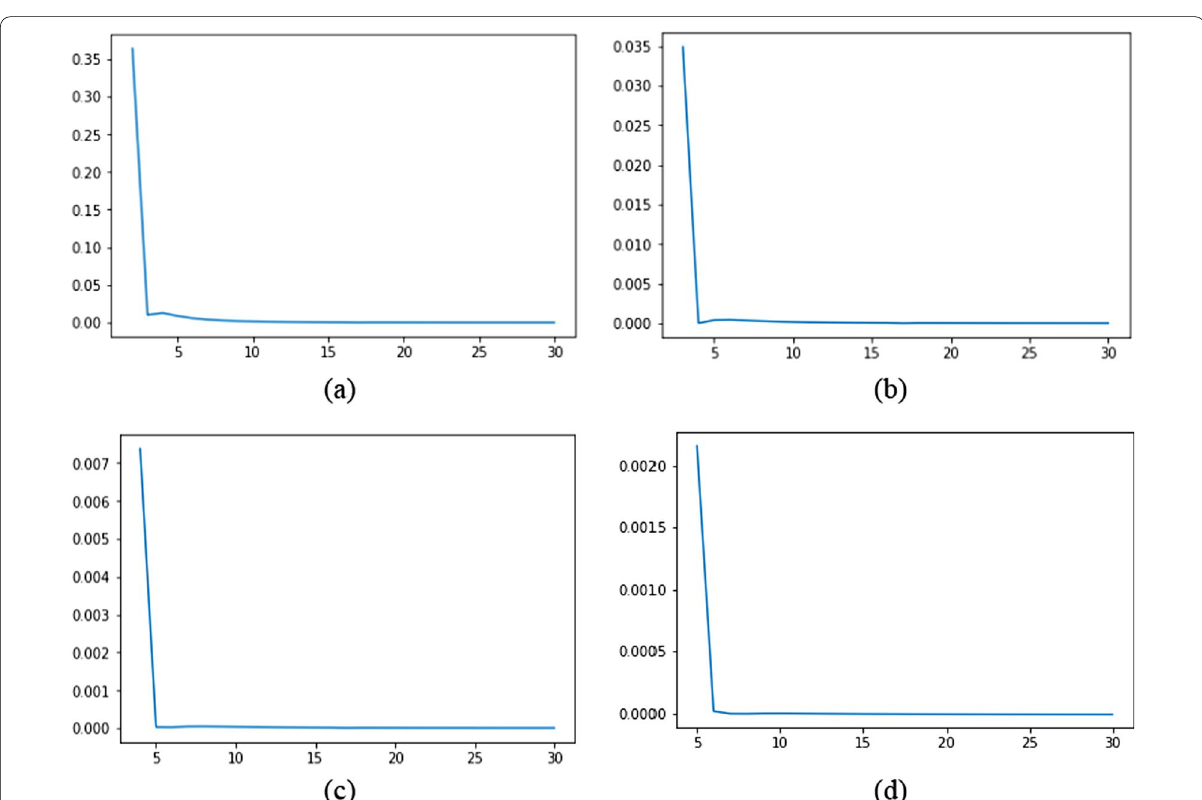
Fig. 1 Transition probabilities as a function of effective principal quantum numbers for the transitions ( a ) np –2 s , ( b ) np–3 s , ( c ) np–4 s , and ( d ) np–5 s . All figures have the same horizontal axis ( n * ) and vertical axis (transition probability (10 8